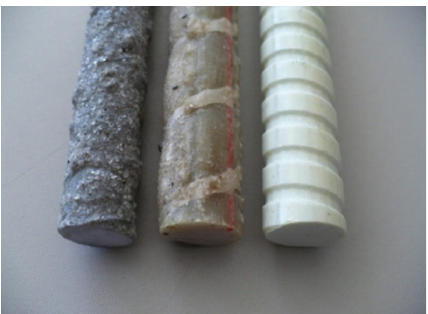
Figure 1: Pultrall V-Rod, Aslan 100, and Sch˝ock ComBAR (left to right) [5].